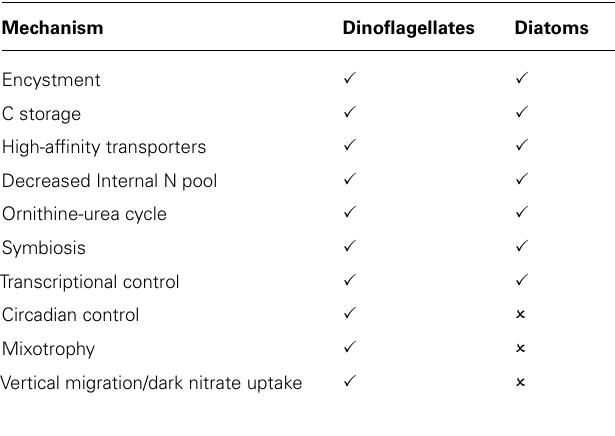
Table 1 | Comparison of adaptation mechanisms to N stress between dinoflagellates and diatoms.